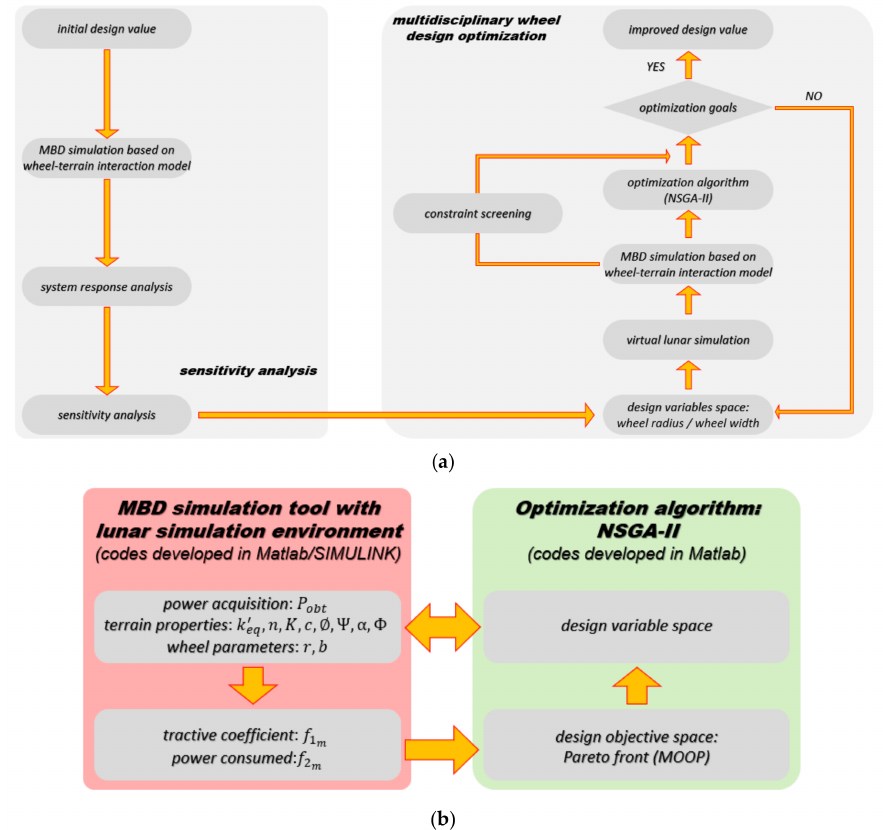
Figure 8. Overall configuration of the proposed sensitivity analysis / multi-objective optimization procedure for solar-powered exploration rover wheel. Non-dominated Sorting Genetic Algorithm-II (NSGA-II): ( a ) framework of the optimization procedure for wheel design of exploration rover; ( b ) data flow for realization of optimization